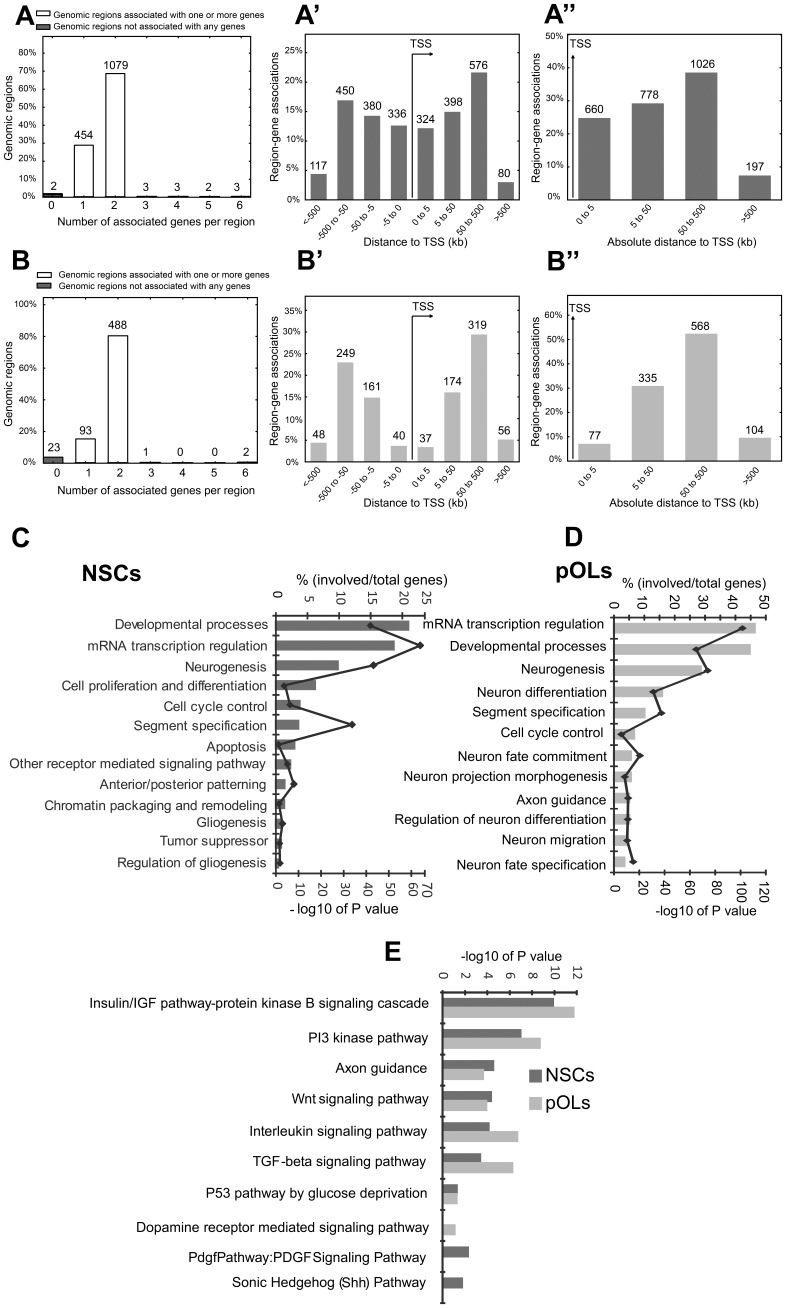
Target genes of Ezh2 in NSCs and pOLs.(A–B”) Association of input genomic regions with the transcription start site (TSS) of all the genes putatively regulated by the genomic regions in NSCs (A–A”) and pOLs (B–B”). (A, B) “Number of associated genes per region" graphs show how many genes in each genomic region is assigned as putatively regulating based on the association rule used. (Details of association rule see online: http://great.stanford.edu/public/html/help/index.php?title=Association_Rules). (A’, B’) Graphs show the distance between input regions and their putatively regulated genes (i.e. binned by orientation and distance to TSS). The distances are divided into four separate bins: 0 to 5 kb, 5 kb to 50 kb, 50 kb to 500 kb, and >500 kb. All associations precisely at 0 (i.e. on the TSS) are split evenly between the [−5 kb, 0] and [0,5 kb] bins. (A”, B”) Binned by absolute distance to TSS (only the distance to TSS is considered, not the orientation). Functional gene ontology (GO) analysis of Ezh2 target genes (DAVID online tool) in NSCs (C) and pOLs (D). The bar graphs represent the percentage of DAVID genes (since DAVID converts user input gene IDs to corresponding DAVID gene IDs) in the list associated with particular annotation term. The corresponding line graphs represent –log10 transformation of the modified Fisher Exact P-value. Fisher Exact is adopted to measure the gene-enrichment in annotation terms. The smaller the P-value, the more enriched a GO term is for genes of the given assay. (E) Comparison of canonical signaling pathways enriched in Ezh2 target genes in NSCs and pOLs.